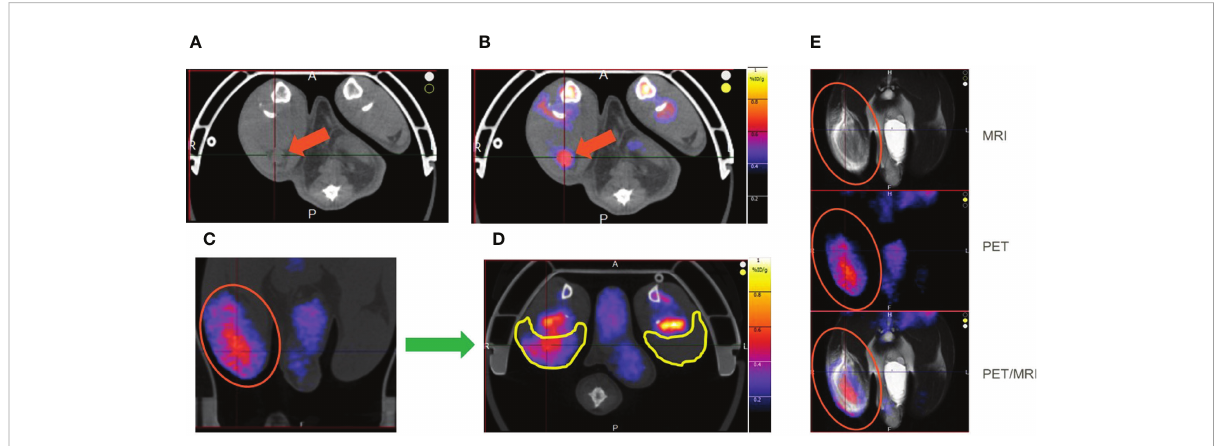
FIGURE 3 18 FDG PET images of rat hindlimb at 24 hr post Prime vaccine injection. Axial CT image with right popliteal lymph node identi fi ed for CMV SAM (A) and with 18 FDG PET image coregistered with the CT image (B) . Hindlimb 18 FDG uptake in CMV SAM in Coronal (C) and Axial (D) planes. Coregistration of MRI and PET images (E) . Orange arrows indicate popliteal lymph node, and yellow ROIs indicate gastrocnemius muscle